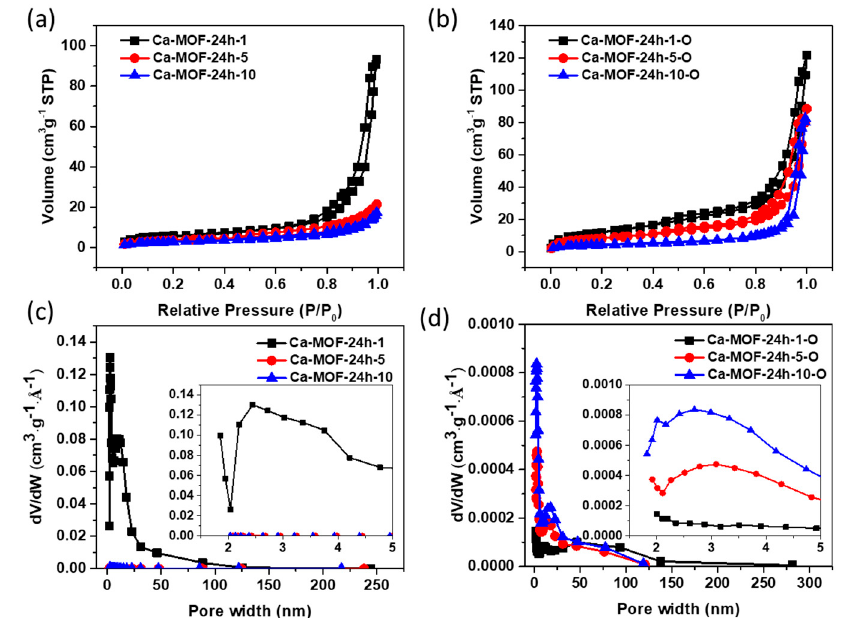
Figure7. N 2 adsorption–desorptionisothermsof( a )Ca-MOF-24h-yand( b )Ca-MOF-24h-y-O;mesopore Figure 7. N 2 adsorption–desorption isotherms of ( a ) Ca-MOF-24h-y and ( b ) Ca-MOF-24h-y-O; size distribution curve of ( c ) Ca-MOF-24h-y and ( d ) Ca-MOF-24h-y-O. mesopore size distribution curve of ( c ) Ca-MOF-24h-y and ( d ) Ca-MOF-24h-y-O. Table 1. The specific surface area and pore size distribution of Ca-MOF-24 h-y and Ca-MOF-24 h-y-O.